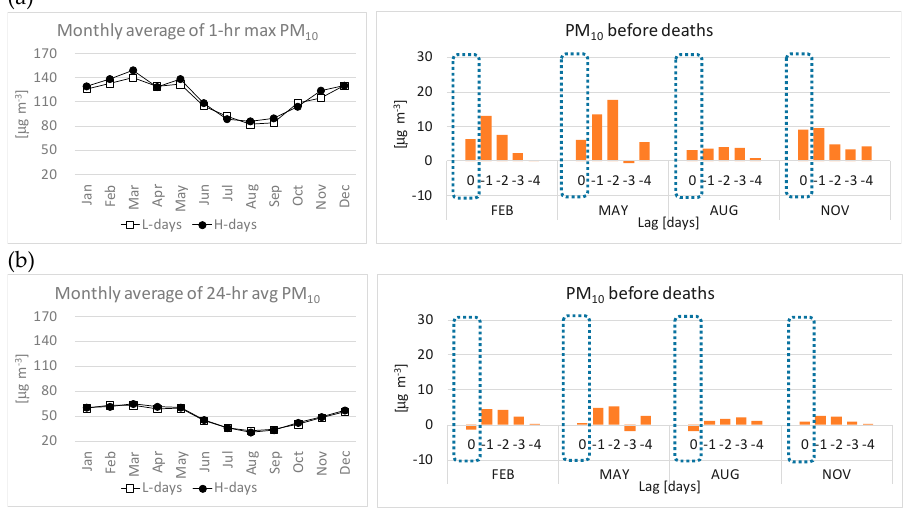
Figure 5. PM 10 concentrations on days with a higher or lower probability of deaths from respiratory disease, and those from zero to 5 days before deaths in February, May, August, and November between 2008 and 2017: ( a ) 1-hour maximum and ( b ) 24-hour average PM 10 concentrations.